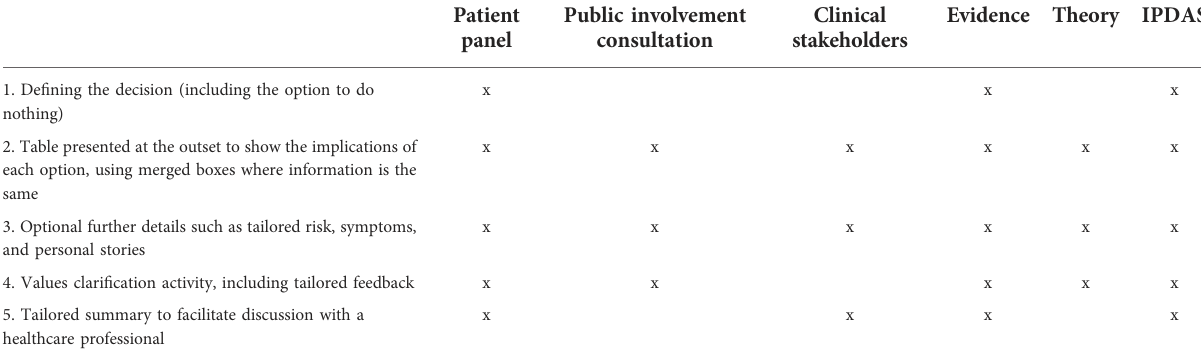
TABLE 3 Sources of evidence informing the inclusion of each component of the decision aid template (©University of